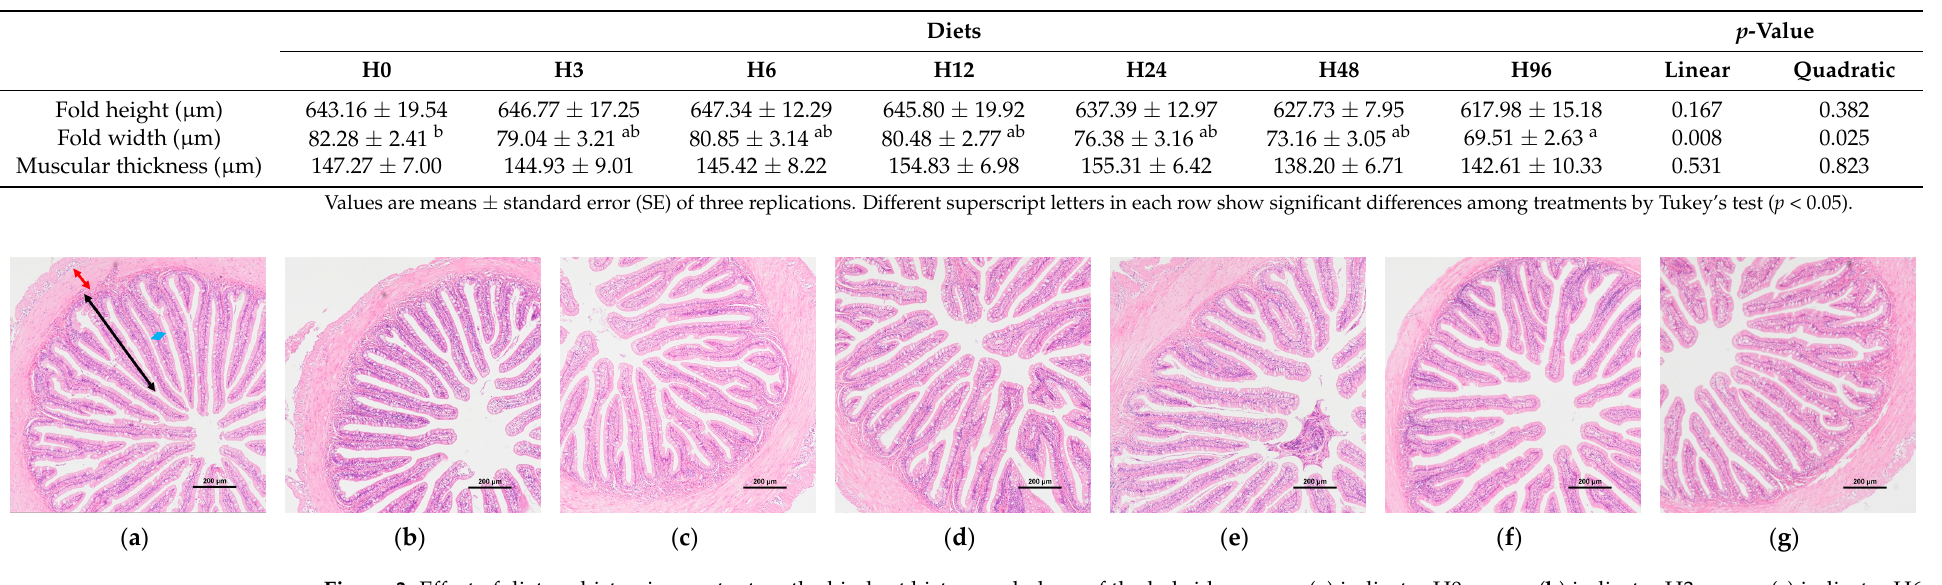
Table 5. Effect of dietary histamine content on the intestinal histomorphology of the hybrid grouper.